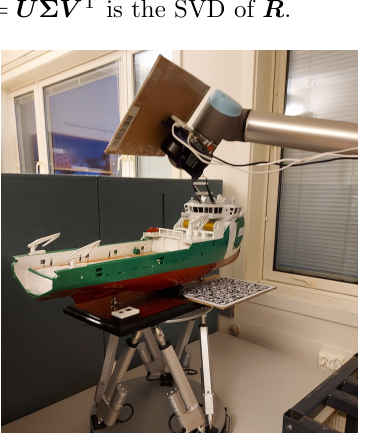
Figure 4: The experiment setup consisting of a Stewart platform with a ship and an IMU attached and a robotic arm with a camera, lidar and an IMU attached at the end effector.